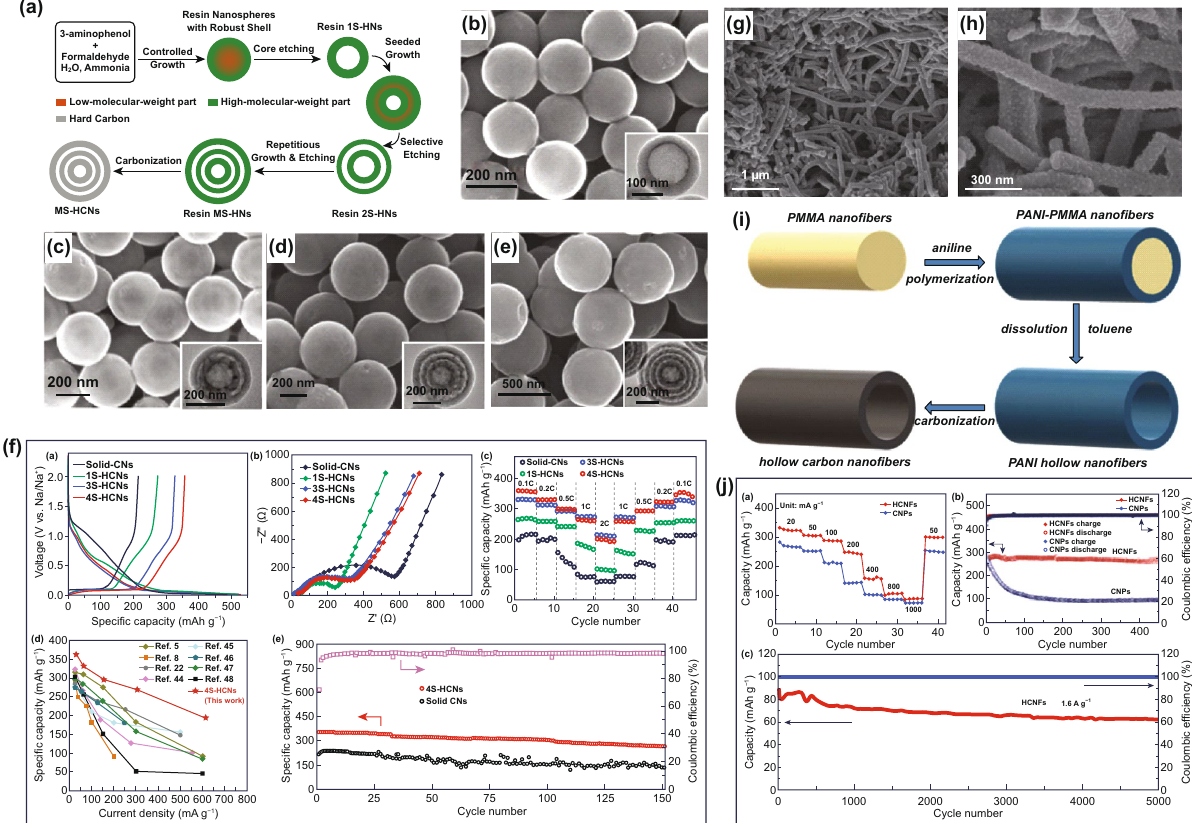
Fig. 9 a Schematic illustration of the synthesis process for MS-NHCM. SEM and TEM images of b 1S-NHCM, c 2S-NHCM, d 3S-NHCM, and e 4S-NHCM samples. f Electrochemical performances of all NHCM electrodes for SIBs. Reproduced with permission from Ref.